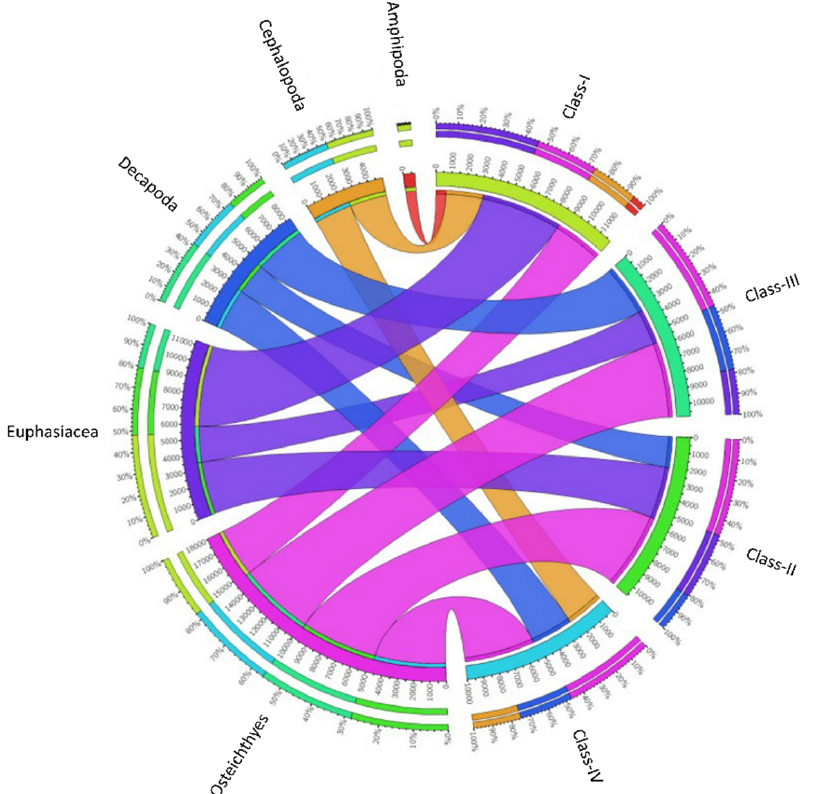
Figure 2. Diet composition of the Merluccius merluccius specimens collected from the southern and central Tyrrhenian Sea during 2018. The chord diagram shows the connection among the main taxa found in the stomach contents of different hake size classes investigated. The size classes analyzed are shown on the right of the diagram. Main taxa found are shown on the left. Ribbon size in the chart codifies IRI value associated with hake size classes/prey taxa segment pair.